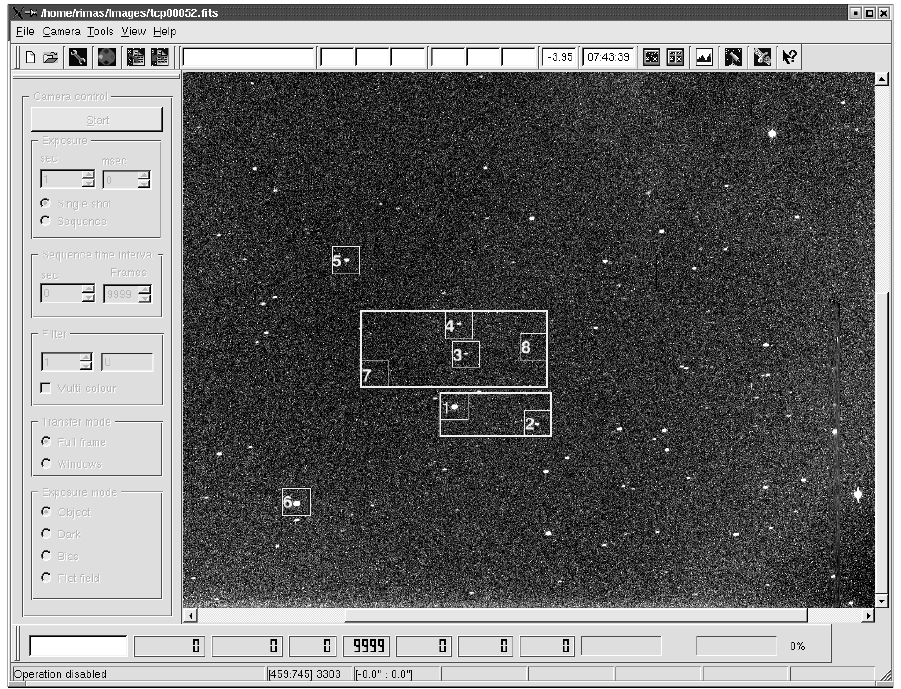
Fig. 2. The main window of the tccp program with selected “windowing” regions in the star